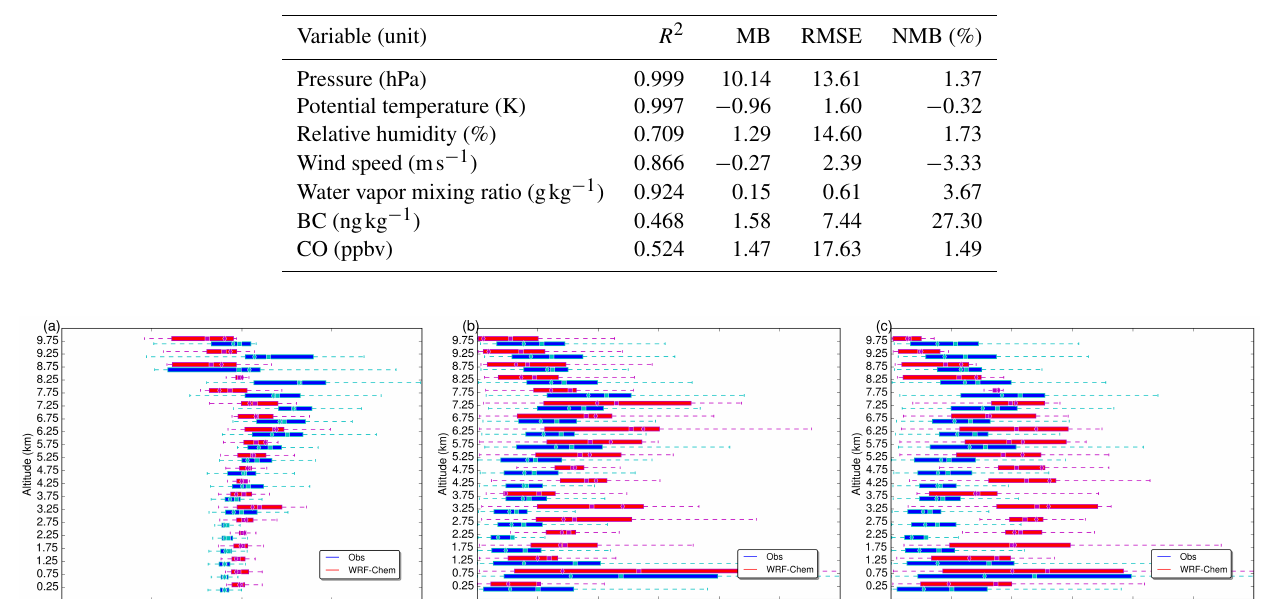
Table 3. Performance statistics for meteorological variables and chemical species (BC, CO). For all flights, R 2 , MB, RMSE and NMB represent the Pearson correlation coefficient, the mean bias, the root-mean-square error, and the normalized mean bias, respectively.